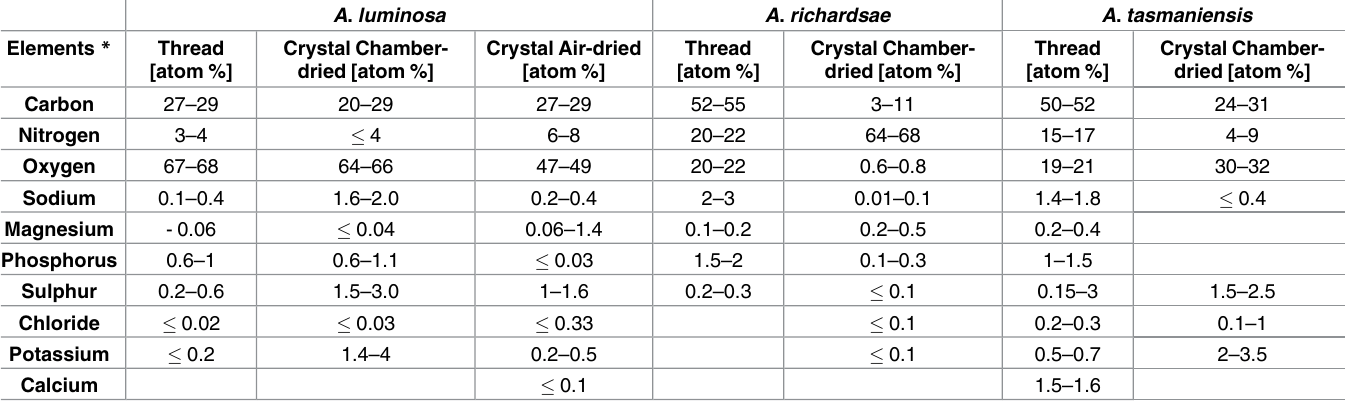
Table 1. EDX values of the different elements and chemicals, given in atomic%, present in the different glowworm species. A .